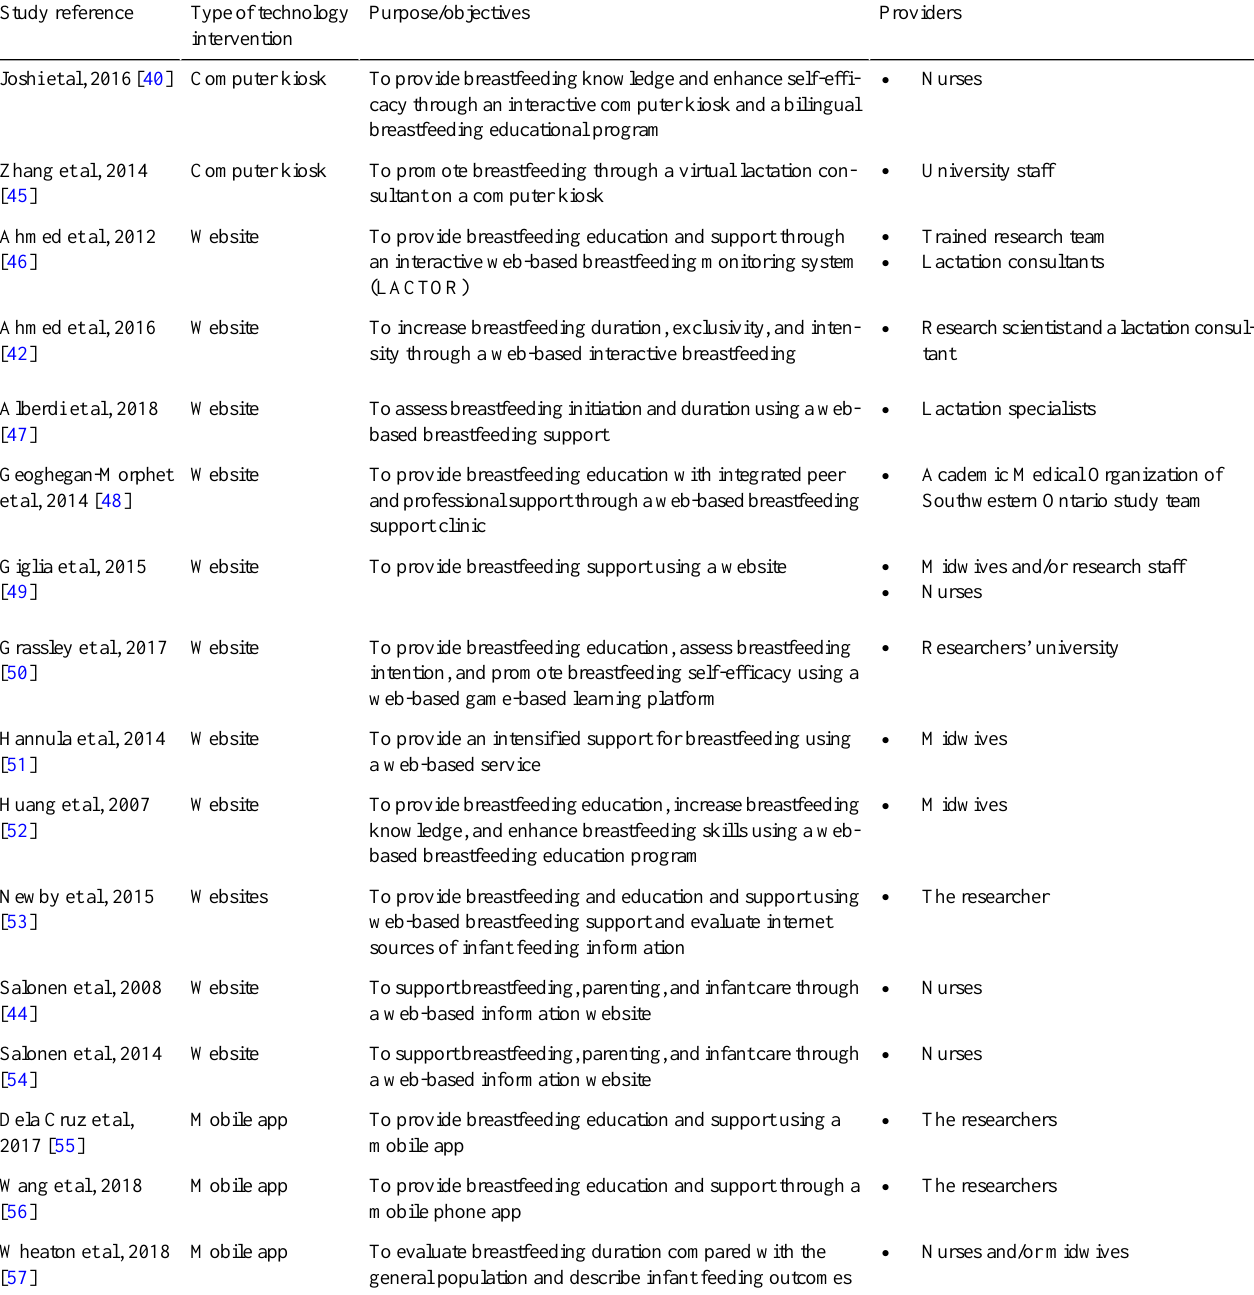
Table 2. Description of internet-based electronic technology interventions. ProvidersPurpose/objectivesType of technology interventionStudy